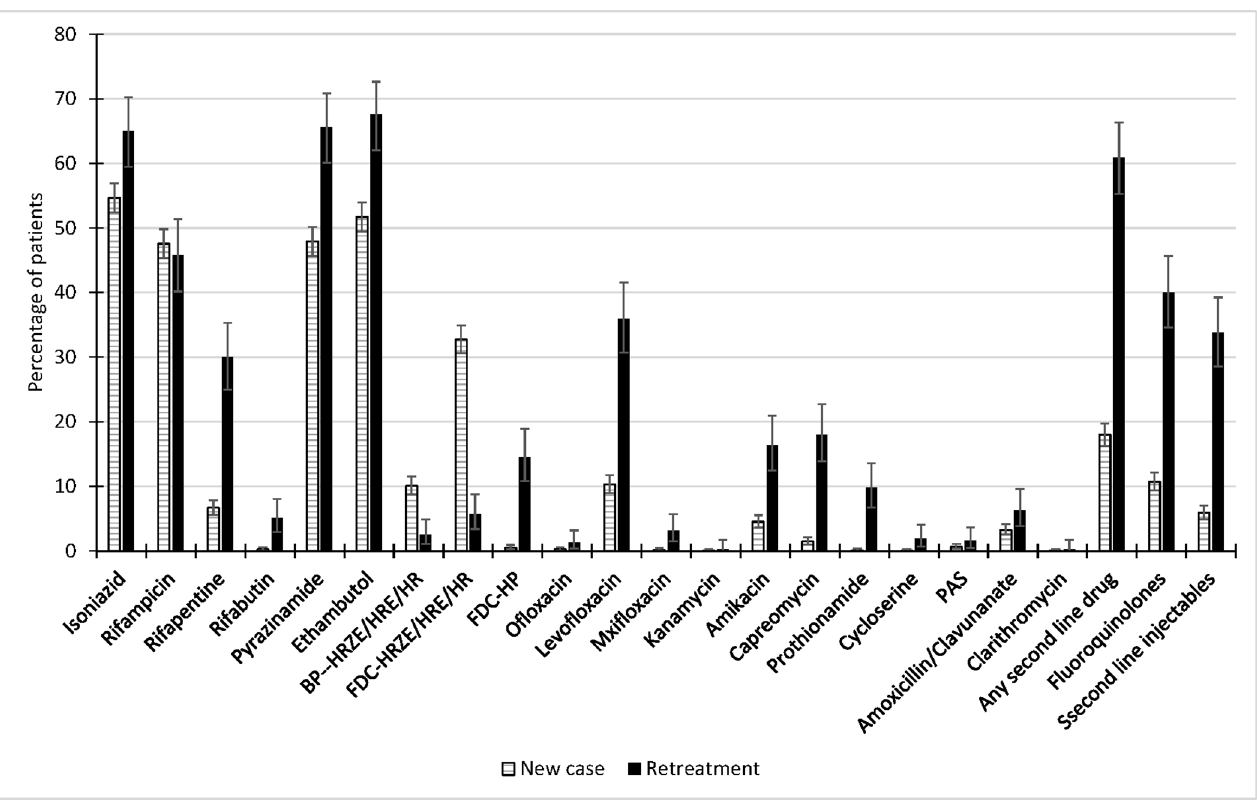
Fig 1. Proportion of tuberculosis patients treated with each type of anti-tuberculosis drugs, with 95% confidence interval, by new and previously treated cases. (fixed dose combination, FDC; isoniazid,H; rifampicin, R; pyrazinamide, Z; ethambutol, E; PAS, P).